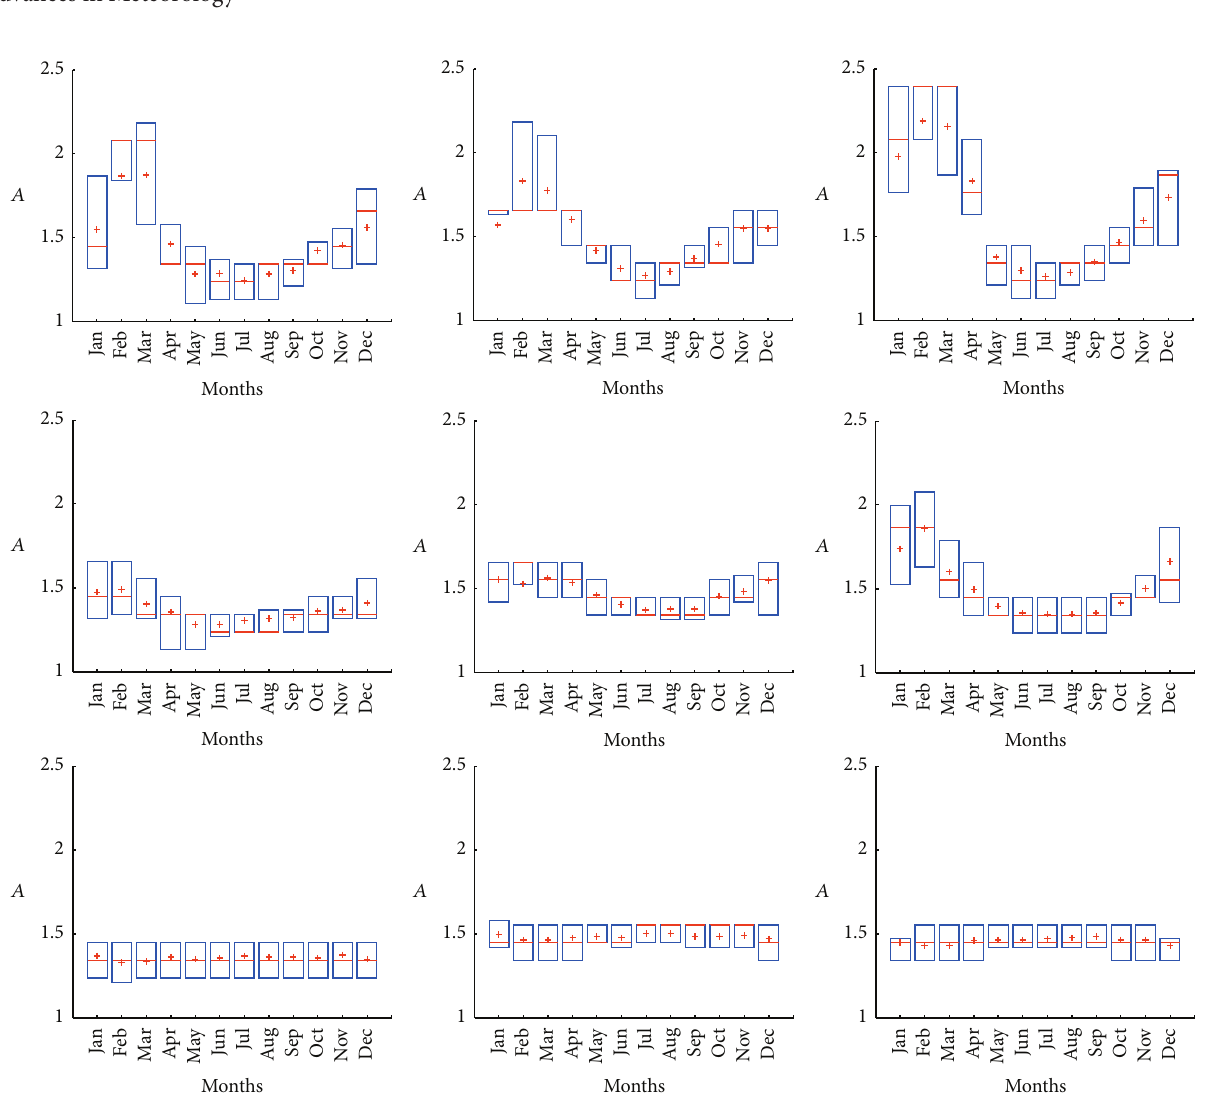
Figure 4: Seasonal variation of parameter 𝐴 based on the DYNIA for the RMSE (left column), TRMSE (central column), and ROCE (right column) OFs and for 3 (top), 7 (middle), and 13 (bottom)